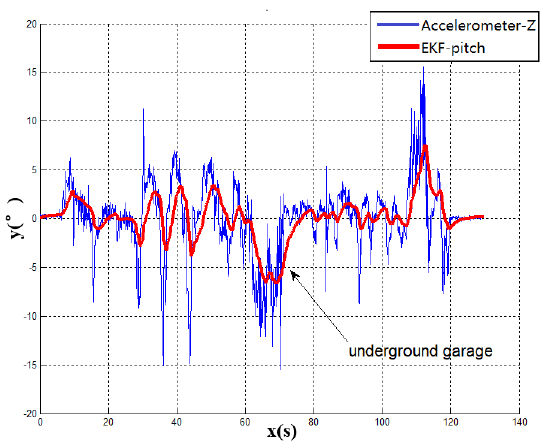
Figure 6. Experiment 1 pitch angle waveform diagram.